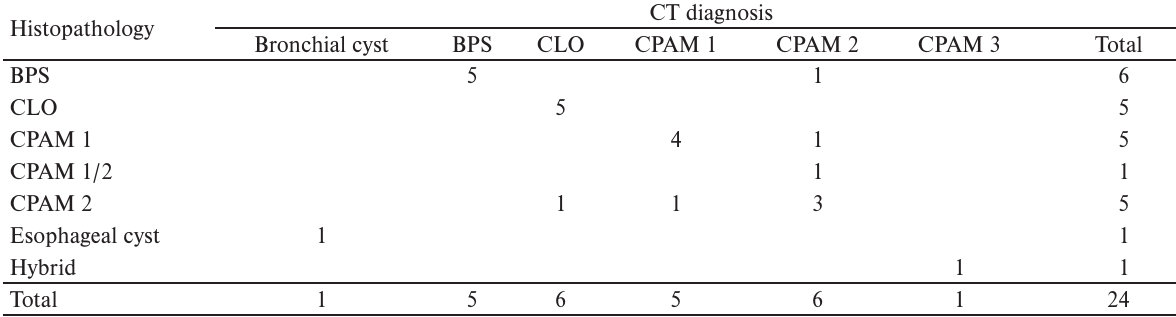
Table 2. Comparison of CT diagnosis and histopathological